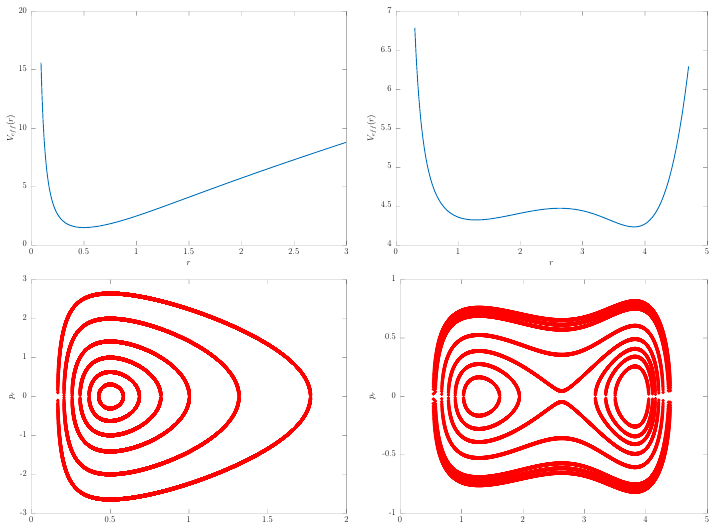
Figure 5. Illustration of the effective potential ( top ) and resulting phase space trajectories ( botom ) arising with a self-consistent magnetic field. Left: A typical situation when a > 0 (here a = 1/4), and φ ( 0 ) = 2; the effective potential is computed with p θ = 0.5 and p z = 3. Right: A situation when a < 0 (here a = 1/4) and φ ( 0 ) = 2, and unstable arises; the effective potential is computed with p θ = 0.5 − − and p z = −